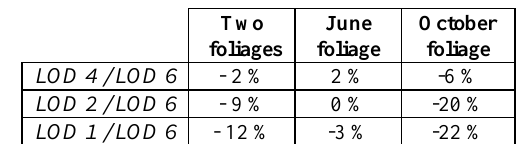
Table 11. Sensitivity of the evapotranspiration on the whole period depending on the LOD and the foliage used